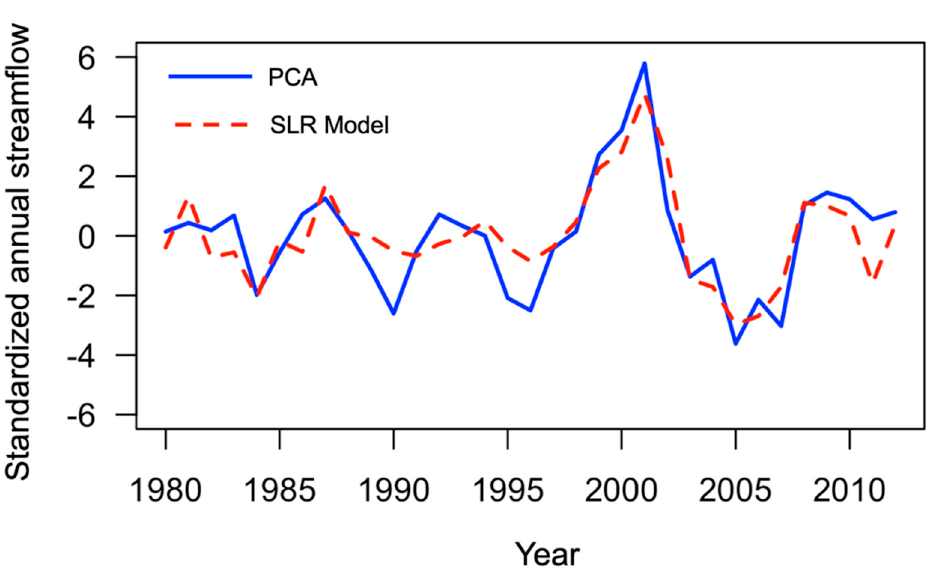
Figure 8. Reconstructed annual standardized streamflow and PCA generated regional annual streamflow vector for overlapping (1980 to 2012) period.